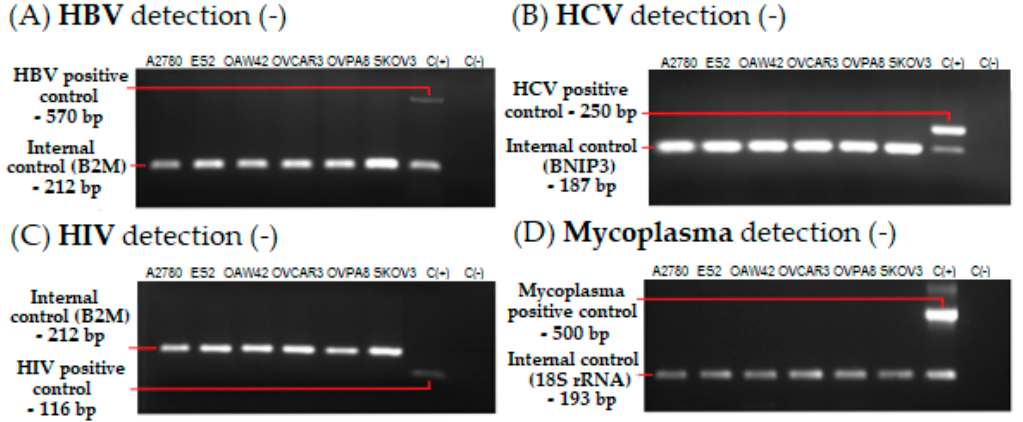
Figure 7. PCR-based detection of HBV ( A ), HCV ( B ), HIV ( C ), and mycoplasma ( D ) infection. Each cell line was found to be free from the viruses. Mycoplasma testing was performed regularly for all cell lines used in the experiments; C(+)—positive control, C( − )—negative control.